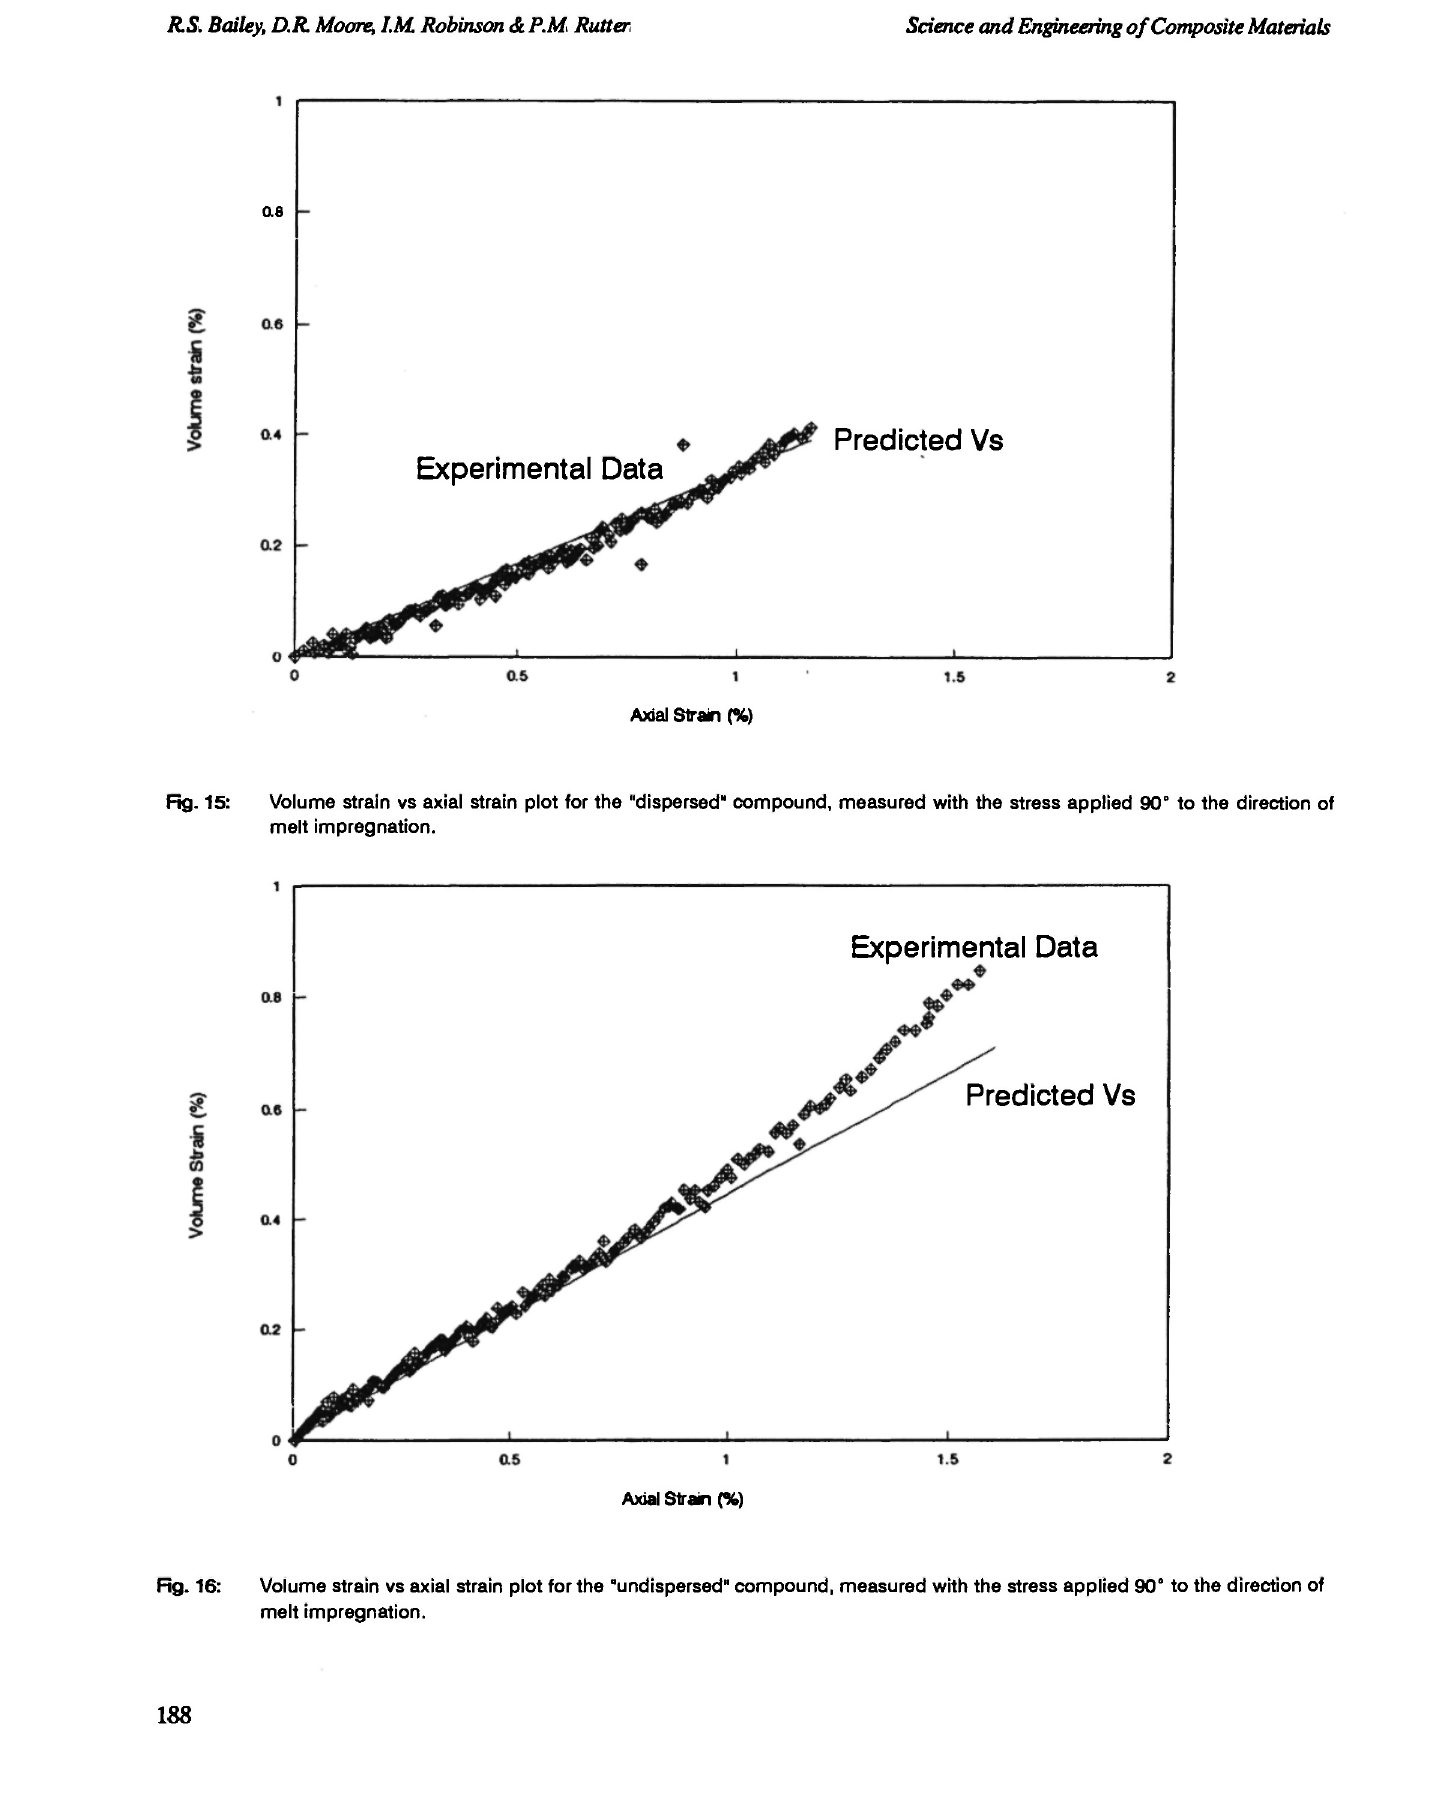
Volume strain vs axial strain plot for the "undispersed" compound, measured with the stress applied 90° to the direction of melt